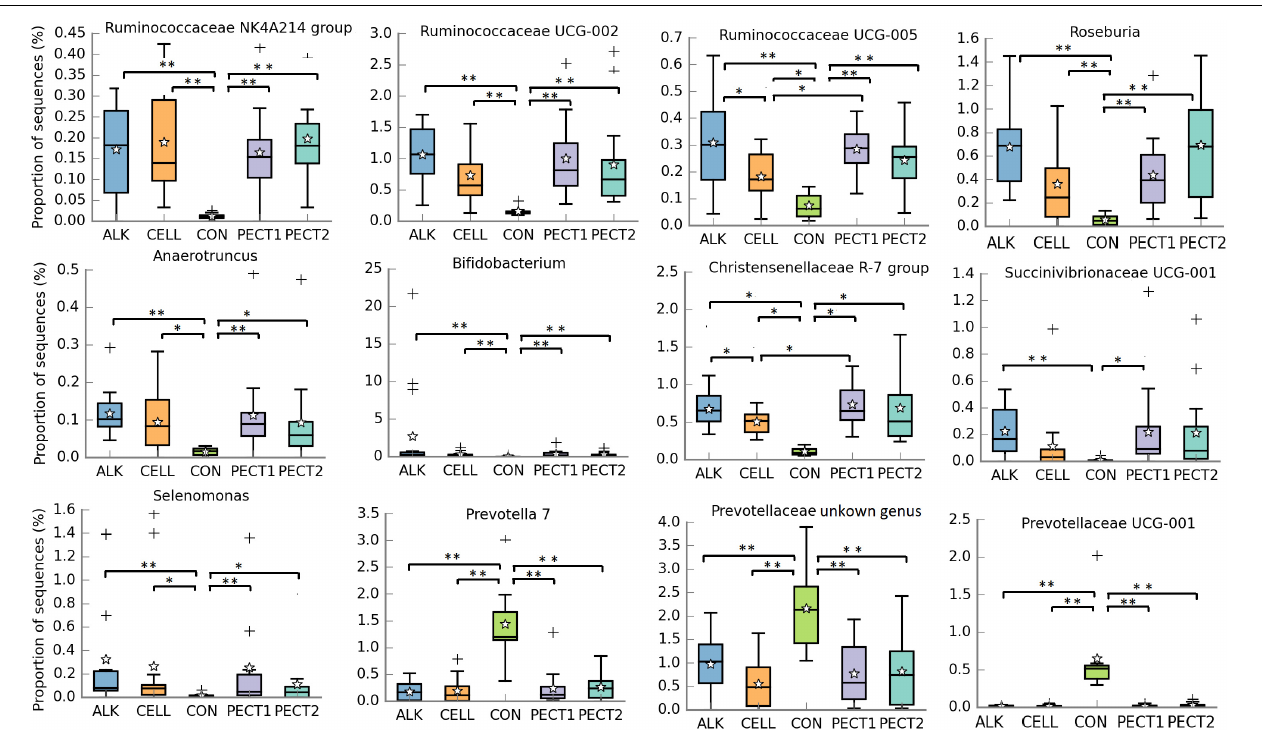
FIGURE 4 | Significantly different relative abundances of microbial genera upon treatment with ALK, CELL, CON, PECT1, and PECT2. The relative abundances of genera in pre-treated RSM compared to CON were analyzed by ANCOVA. * P < 0.05; ** P < 0.01. The stars represent the group means while the middle bars of the boxplots represent the median and the plusses represent